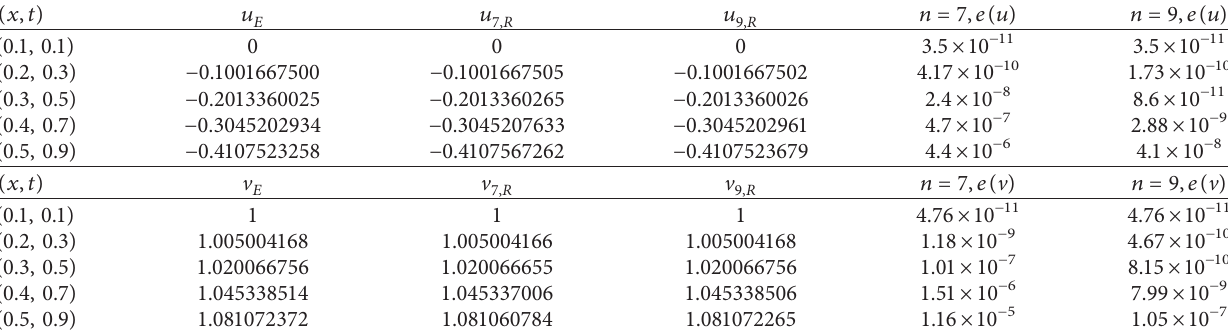
Table 9: Numerical result of Example 8.